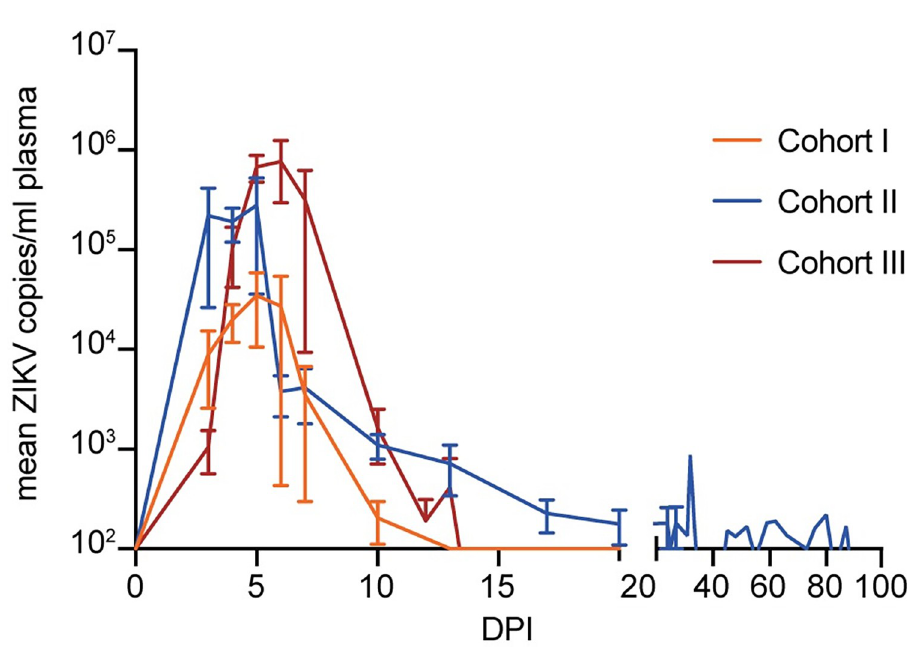
Fig 2. Maternal ZIKV plasma viremia. ZIKV viremia in macaque plasma. Copies of viral RNA were detected by ZIKV-specific RT-qPCR. Mean ZIKV plasma viremia are displayed in orange for Cohort I, blue for Cohort II (SIV-/ ZIKV+ +ART), and red for Cohort III (SIV-/ZIKV+). Bars represent the standard error of the mean (SEM).